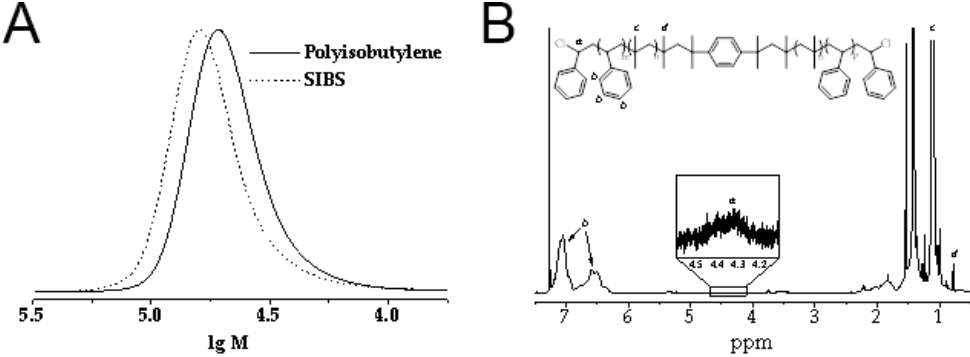
Figure 2. ( A ). Gel permeation chromatography (GPC) curves of the polyisobutylene middle block and the SIBS block-copolymer. ( B ). 1 H NMR spectra of resultant